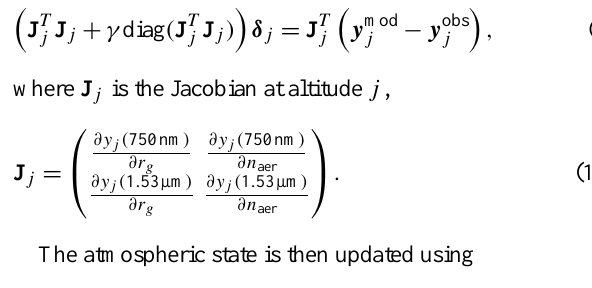
Fig. 8. Averaging kernels for the simulated extinction and mode radius retrievals using lines of sight spaced at 1km intervals. Left panel shows the extinction averaging kernels with the mode radius averaging kernels shown on the right. The black line shows the vertical resolution calculated from the full-width half-max of the kernels.